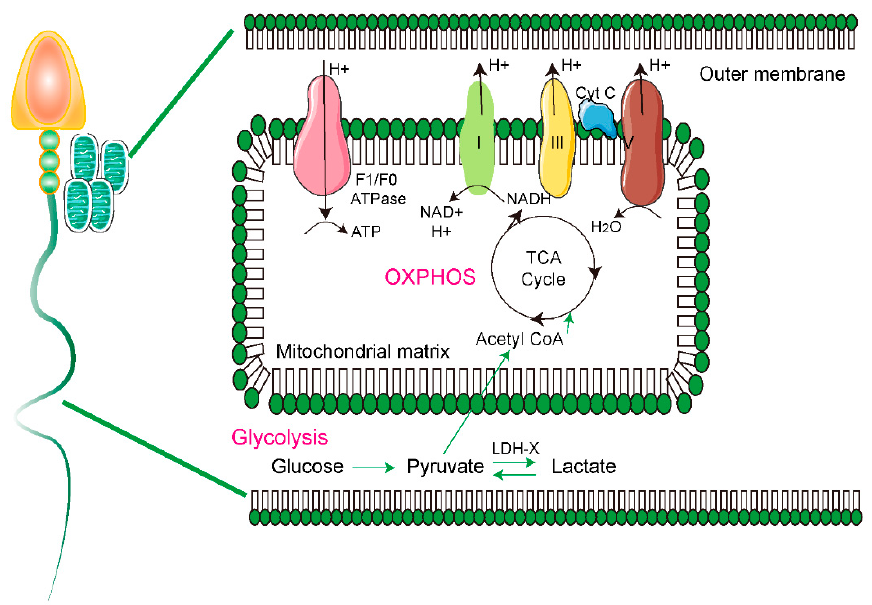
Figure 1. Schematic image of OXPHOS and glycolysis in spermatozoa. Pyruvate is produced by glycolysis and is then converted to lactate in the principal piece of spermatozoa by lactate dehydrogenase. Then, pyruvate in the principal piece is transported inside into the mitochondria and it is used as fuel for TCA cycles, which produce the NADH. OXPHOS take place in mitochondria of sperm midpiece. Oxidation of NADH in the electron transport chain produce the ATP molecules by OXPHOS.